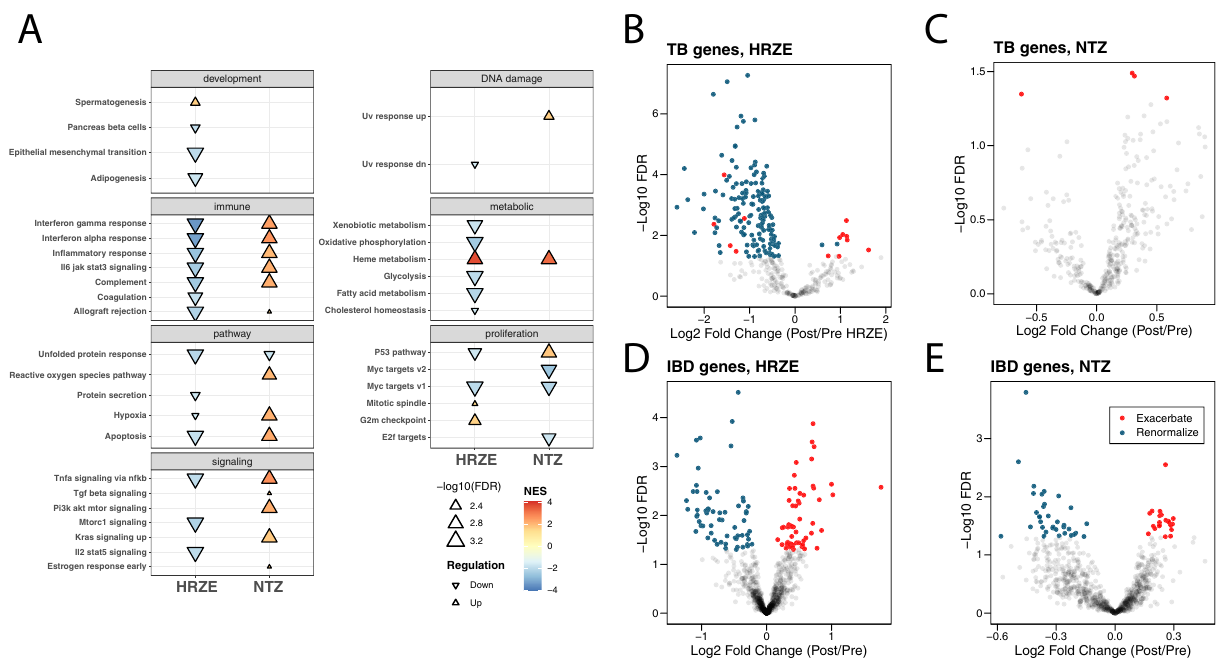
Fig. 4 Hallmark pathway gene set enrichment analysis and gene expression comparison in HRZE and NTZ treated arms. A Hallmark gene pathway changes associated with 2 weeks of HRZE ( A ) or NTZ ( B ). Positive are pathways overrepresented at 2 weeks of therapy (up), and negative are pathways underrepresented at 2 weeks (down), both compared to baseline. All pathways are signi fi cant (FDR < 0.05, see Supplementary Data 6) with the size of the arrow indicating level of signi fi cance. Only pathways from MiSigDB Hallmark pathway set found to be signi fi cantly altered in this analysis are shown. Here NES stands for Normalized Enrichment Score. B , C TB-associated peripheral blood transcripts from ref. 19 , highlighting post treatment vs baseline changes in gene expression for HRZE ( B ) or NTZ ( C ). Notably, HRZE renormalizes (i.e., towards a healthy control state) the expression of 144 validated TB in fl ammatory transcripts and exacerbates only 13 (see Supplementary Data 7). NTZ is found only to exacerbate four (see Supplementary Data 8). TB- associated peripheral blood transcripts signi fi cantly affected by each treatment were those determined to have a Benjamini – Hochberg false discovery rate (FDR) adjusted p -value less than 0.05 for the variable Group in the limma/voom model (see “ Methods ” section). D , E Effect of HRZE and NTZ on blood gene expression for a set of IBD-associated genes from Palmer, et al. 41 . Both HRZE ( D ) and NTZ ( E ) cause different genes to either renormalize (HRZE 66, NTZ 34) (see Supplementary Data 9) or exacerbate (HRZE 55, NTZ 21) (see Supplementary Data 10). IBD-associated peripheral blood transcripts signi fi cantly affected by each treatment were those determined to have a Benjamini – Hochberg false discovery rate (FDR) adjusted p -value less than 0.05 for the variable Group in the limma/voom model (see “ Methods ” section) P value in y axis is adjusted according to Benjamini – Hochberg (FDR). Source data are provided as a Source Data fi